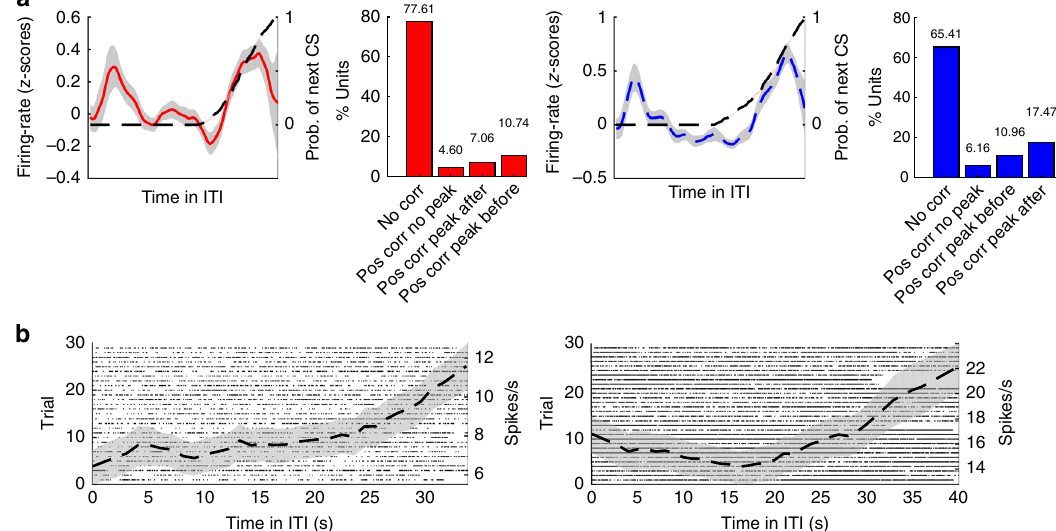
Fig. 9 Activity at the end of the ITI. a Empirical hazard rate for the CS over all trials (black dashed line, right y -axis). A subpopulation of cells in the amygdala (left/red; 22.39%) and dACC (right/blue; 34.59%) showed a signi fi cant positive correlation with the rising phase of the daily hazard rate (shown is the mean z -scored fi ring rate with S.E.M., left y -axes). Within these signi fi cant hazard cells, the majority manifested a signi fi cant peak in activity during the ITI, either before the minimal ITI duration (amygdala 7%; dACC 10.96%) or following it (amygdala 10.74%; dACC 17.47%). Time and neural activity were warped for averaging and presentation purposes. b Rasters and PSTHs from amygdala (left) and dACC (right) single units that had a signi fi cant correlation with the daily hazard rate (up to 0.75, see methods). Data presented as mean ±